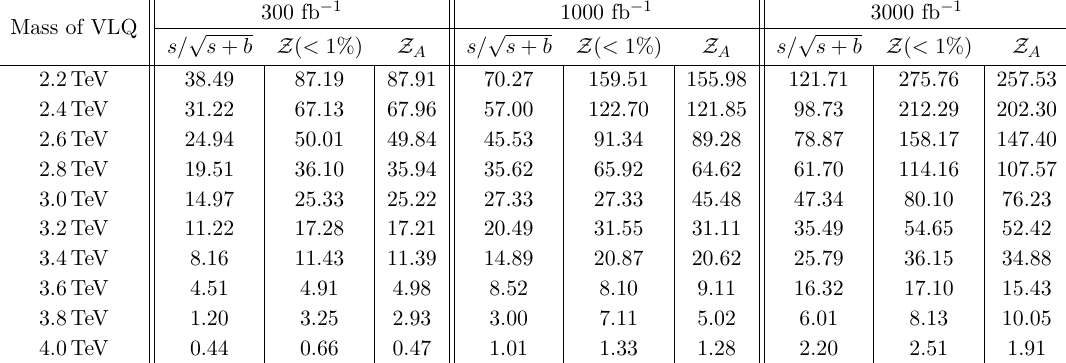
Table 9. Signal significance for the lightest VLQ-pair production. The computation follows a genetic algorithm that maximizes the Asimov significance metric. All significances are computed for proton-proton collisions at the centre-of-mass energy of